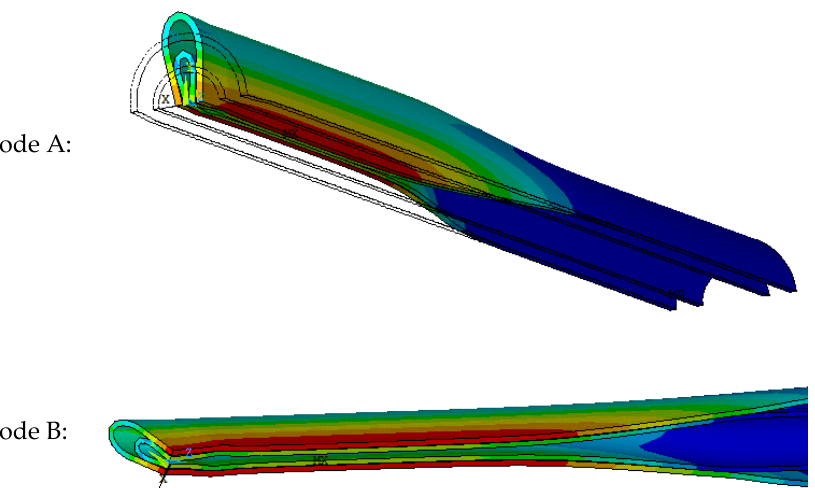
Figure 2. Two different buckle propagation modes in a PIP system.